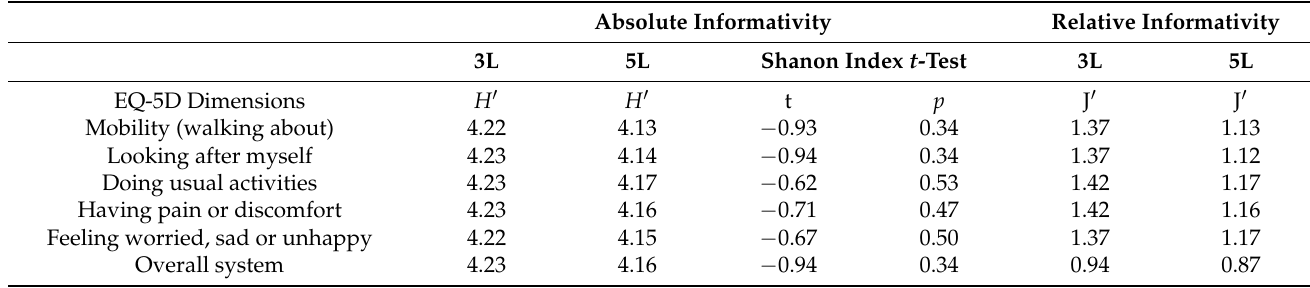
Table 5. Absolute and relative informativity of EQ-5D-Y-3L and